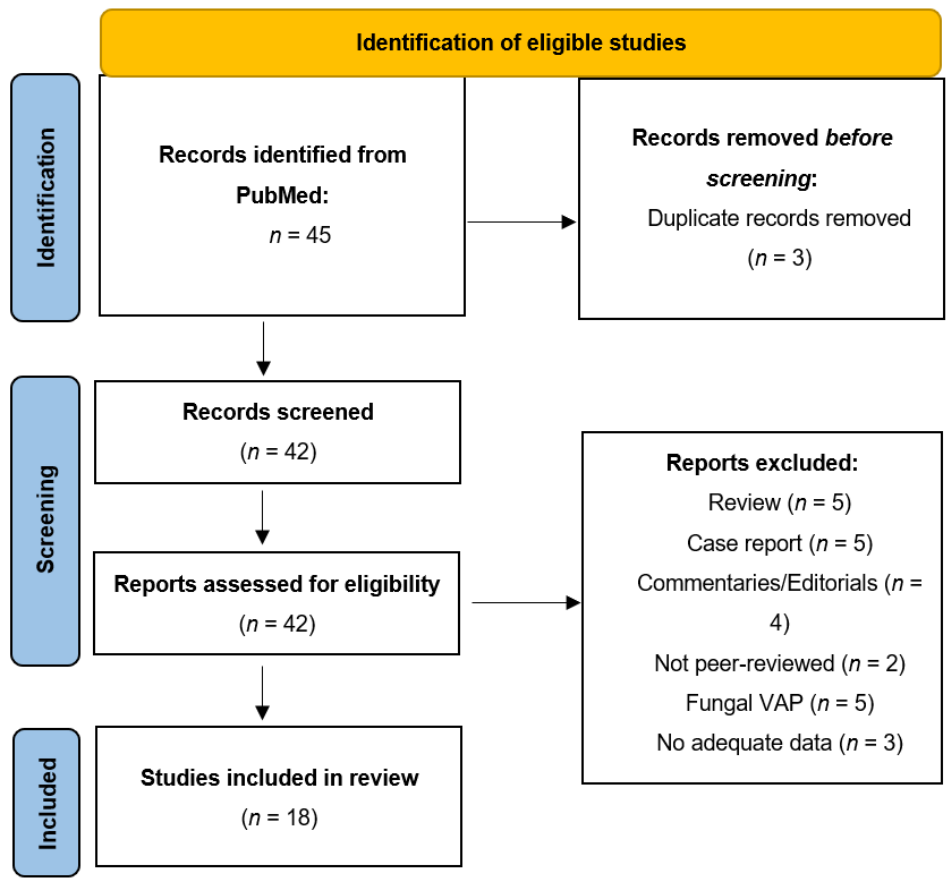
Figure 1. Flow diagram for records identification and screening. Ventilator-associated pneumonia (VAP). Legend: Ventilator-associated pneumonia (VAP).